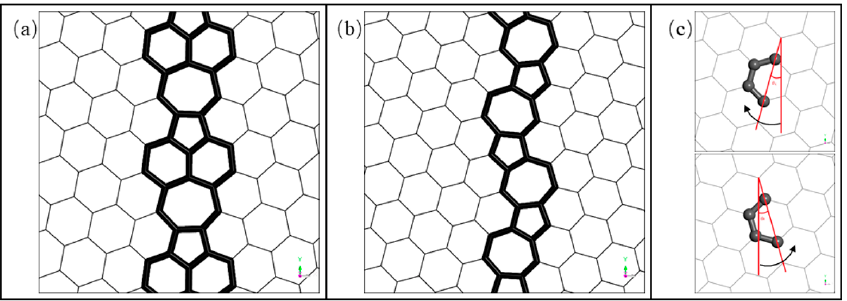
Figure 1. ( a ) Grain boundaries with misorientation angle of 21.8°; ( b ) grain boundaries with misori- entation angle of 30°; ( c ) the cell used in modeling and the rotation mode.